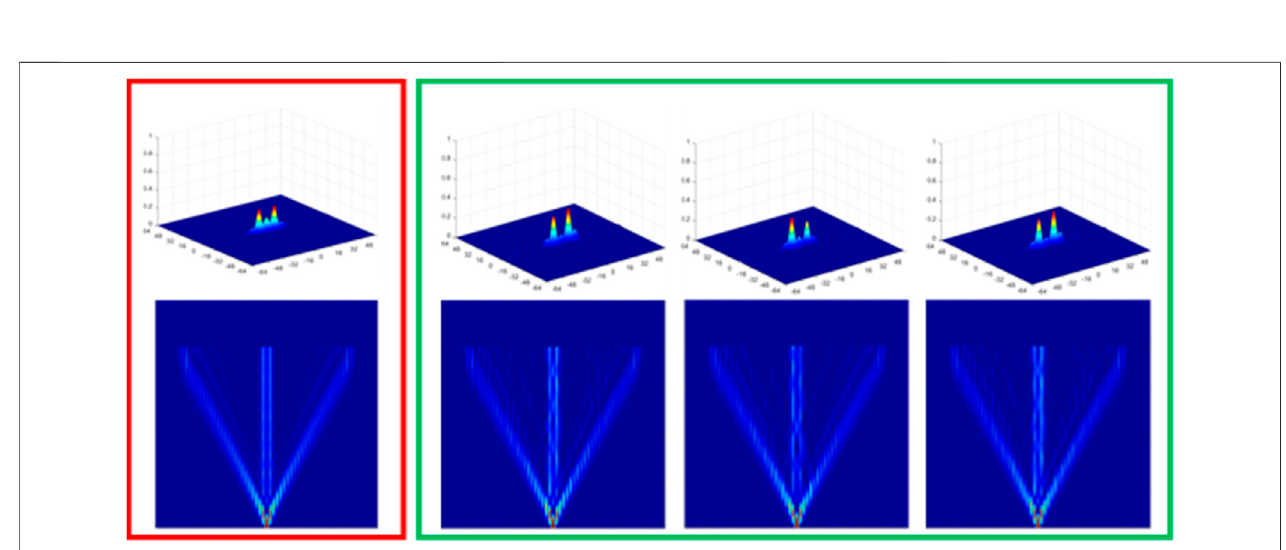
FIGURE 9 | Light propagation in BPL A2 of 49 cores in which cores are placed 5% randomly disordered around their ideal, regular positions.